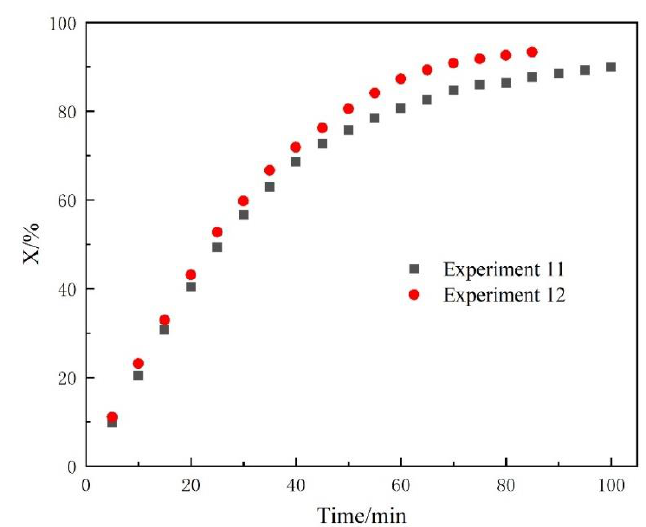
2 2 𝑋 − (1 − 𝑋) 3 vs time in different proportions 3 2 X − ( 1 − X ) 2 3 vs time in different proportions 2 3 𝑋 − (1 − 𝑋) 3 vs time in different proportions 3